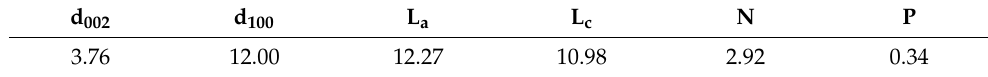
Table 13. Microcrystalline structural parameters of Kerjian coal samples.